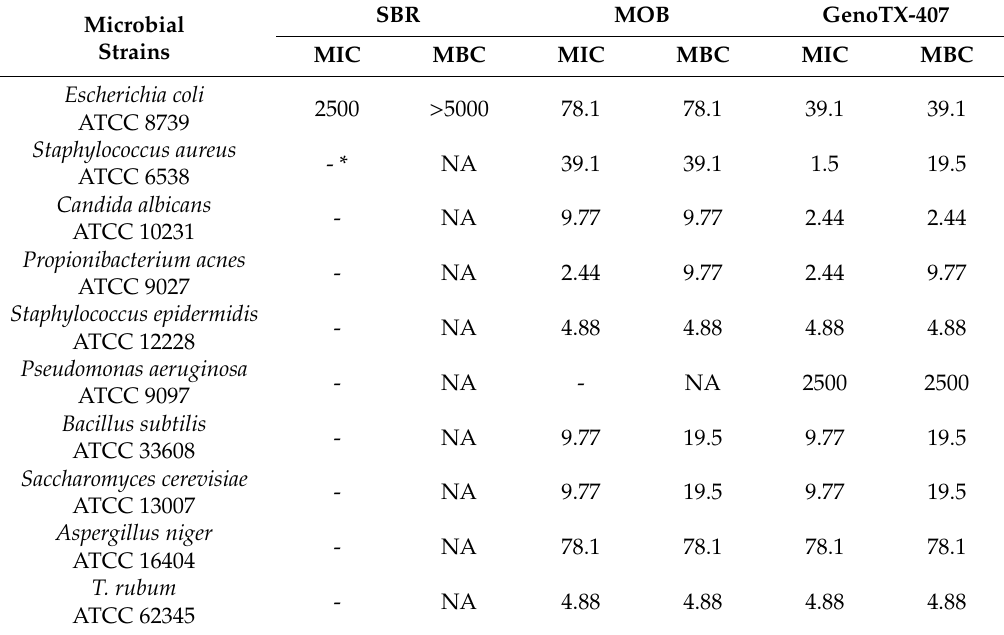
Table 3. The Minimum inhibitory concentration (MIC) and minimum bactericidal concentration (MBC) ( µ g / mL) of SBR, MOB, and GenoTX-407, a combination of SBR and MOB, against pathogenic